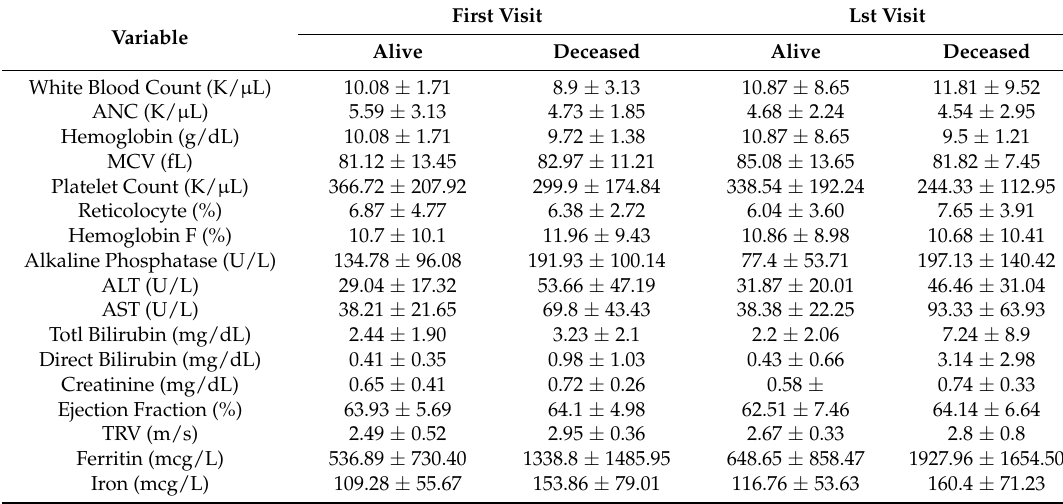
Table 3. Hematologic and Organ Function Parameters in Patients Alive and Deceased at First and Last Visit.